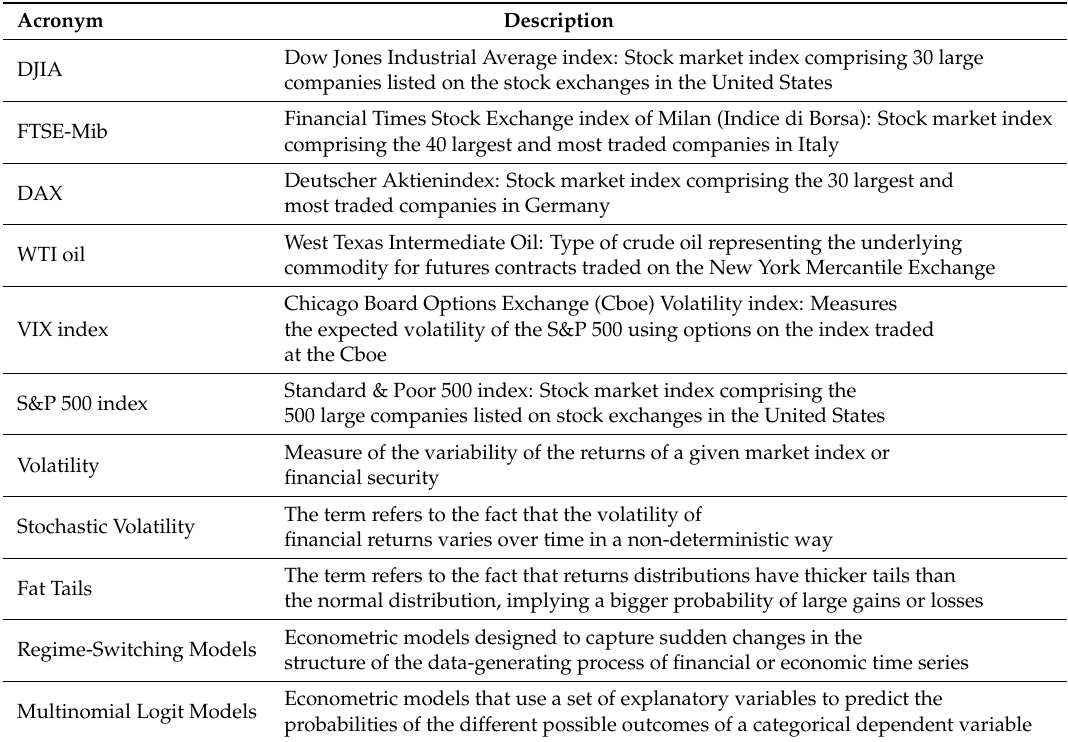
Table A1 provides a list of acronyms and key concept used in the paper. Table A1. List of acronyms and key concept used in the